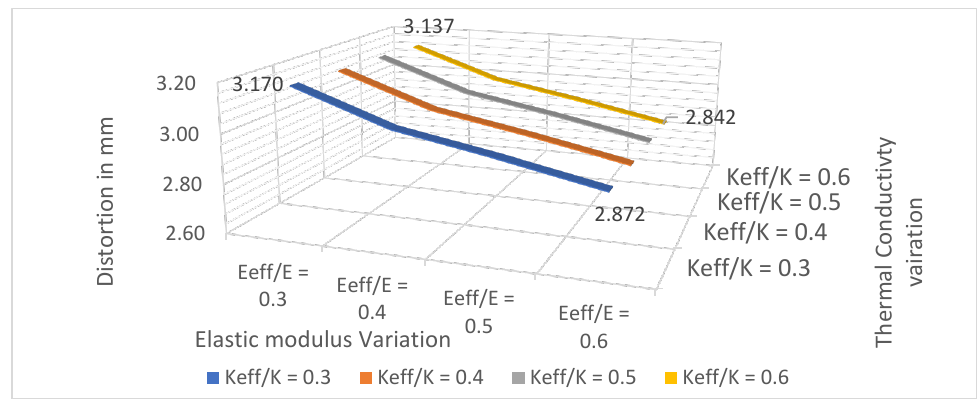
Figure 17. Effective property sensitivity study on a homogenized model to understand FEA soft- ware.